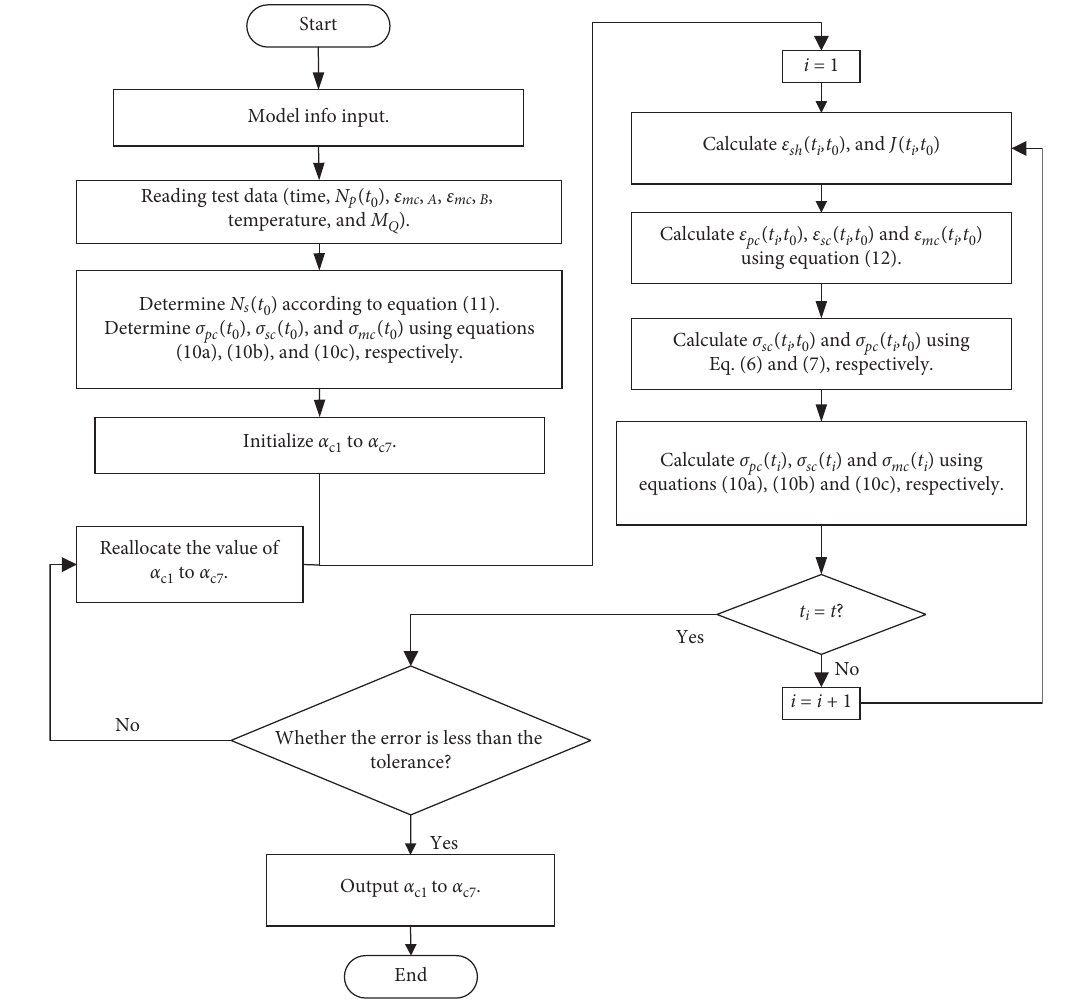
Figure 9: Flow chart for determining the parameters. Table 4: The original value and adjusted value of the